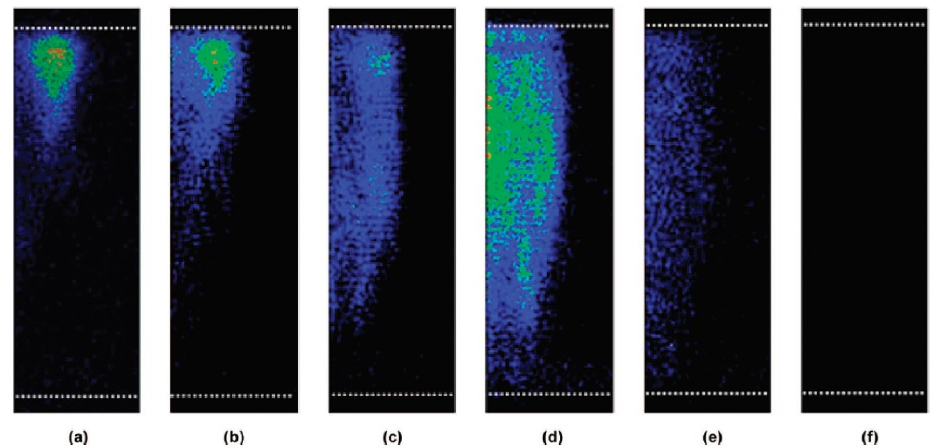
Figure 24. Images showing the effect of dissolved oxygen concentration on the MBSL structure taken from the side of the vessel: ( a ) 8.5, ( b ) 7.0, ( c ) 5.6, ( d ) 4.2, ( e ) 3.4, and ( f ) 2.9 mg/L [59]. The white dotted lines above and below the MBSL structure denotes the liquid surface and the transducer position, respectively. Continuous sonication at a frequency of 448 kHz and a power of 1.1 W/cm 2 was applied. Exposure time was set to collect 2 × 10 5 acoustic cycles. The center axis of the vessel is located on the left side of the images. Copyright 2008, with the permission from American Chemical Society.